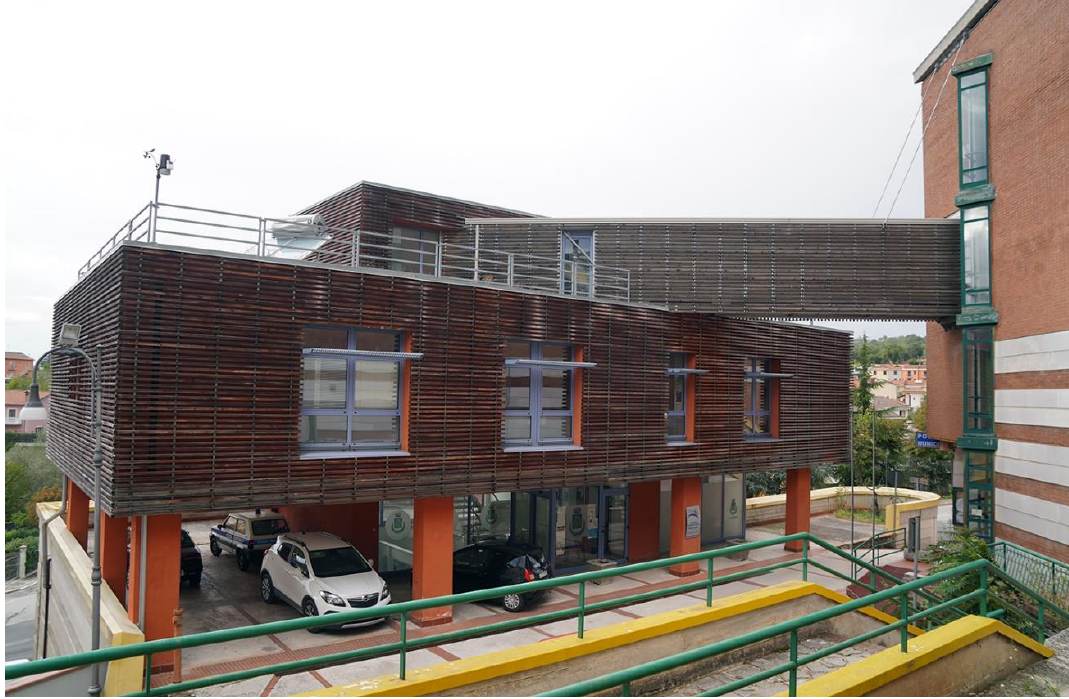
Figure 25. Lioni: part of modern Town Hall built by the architect A. Verderosa (1984–1994) (photos by [35,36]).